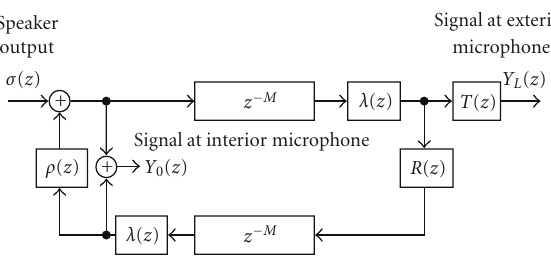
Figure 4: Waveguide model of a cylindrical tube adapted from Figure 1, with microphone capturing signal response Y 0 ( z ) at the bore base, and a colocated speaker having a transmission function of σ ( z ) and a reflection function of ρ ( z ). At the opposite end, there are three possible terminating conditions relating to instruments I1, I2, and I4: (1) I1: R (z) = 1 and T ( z ) = 0 for a perfectly closed tube, (2) I2: R ( z ) = R L ( z ) and amplitude complementary T ( z ) = T L ( z ) = 1 + R L ( z ) for an open cylinder, and (3) I4: R ( z ) = R b ( z ) and T ( z ) = T b ( z ) for the appended trombone bell. Instrument I3 is described by the diagram in Figure 11.